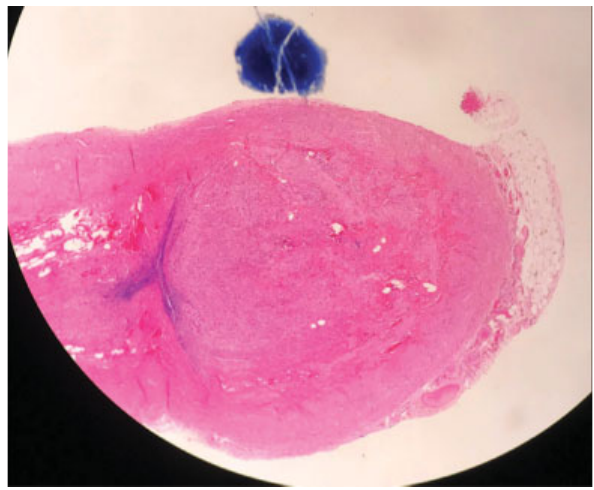
Fig. 1 H&E stain demonstrating a mass at the tip of the appendix. H&E, hematoxylin and eosin.